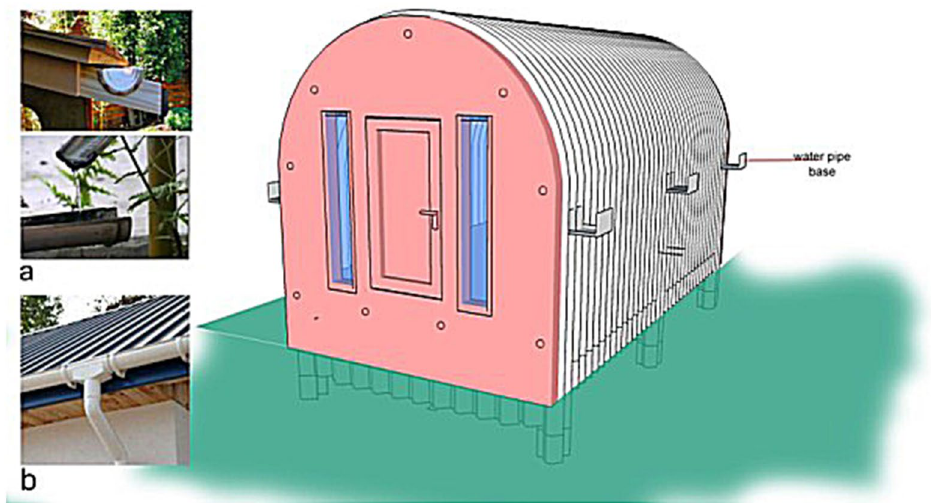
Fig. 13 Water pipe with base in the shelter (removable to clear dust and